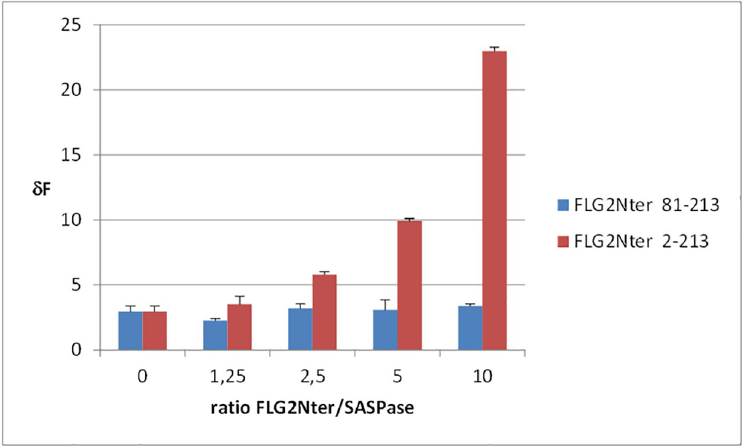
Fig 5. FLG2Nter activates SASPase proteolytic activity in vitro . An in vitro enzymatic assay using recombinant proteins of 28 kDa SASPase (0.5 μ M), and FLG2Nter (aa 2–213) and FLG2Nter (aa 81–213) at different mass ratios to SASPase 28 in the presence of a fluorescent-labeled peptide Dabcyl-QIDRIMEK-Glu(Edans)-NH2 (0.1 mM). The histogram presents the mean values (+/-SD) of each assay performed in triplicate.